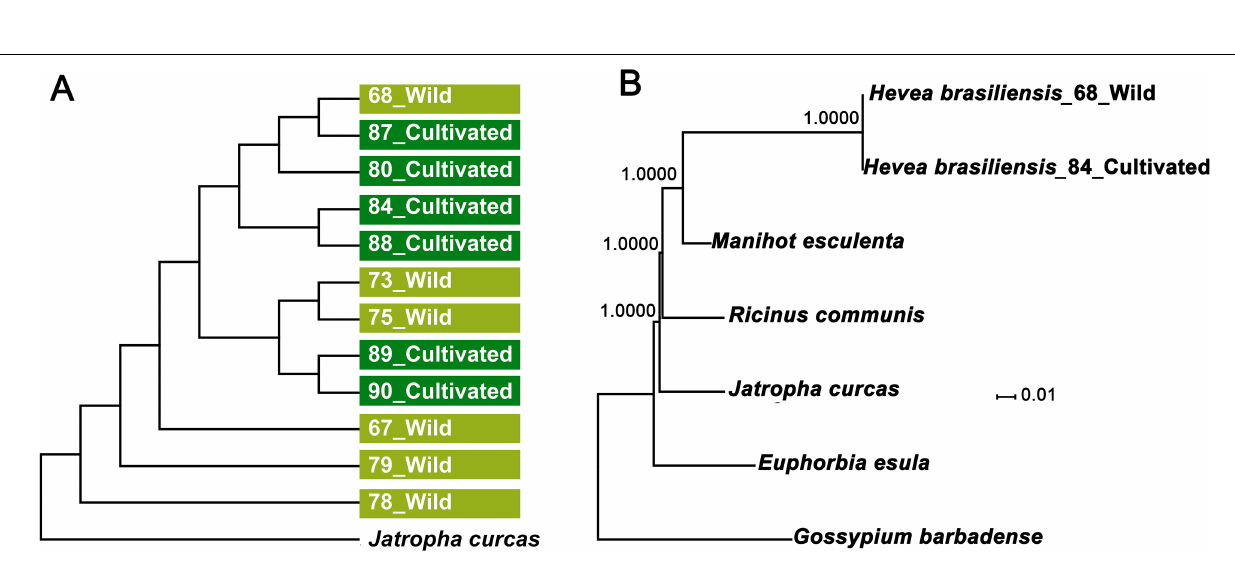
Frontiers in Ecology and Evolution |